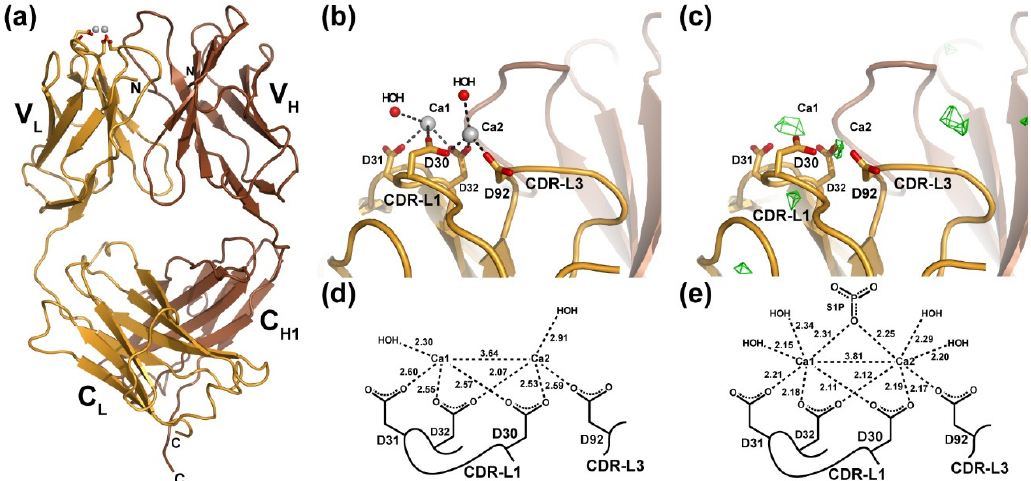
Figure 1. X-ray crystal structure of the LT1009 anti-sphingosine-1-phosphate antibody Fab fragment in complex with Ca 2+ . ( a ) The complete LT1009 Fab fragment is depicted in a ribbon diagram representation with the light chain in gold and the heavy chain in brown. Two Ca 2+ ions are represented as light grey spheres with the side chains that partially coordinate them shown as sticks. Individual immunoglobulin domains are labeled as are the N- and C-termini of the heavy and light chains. ( b ) A close-up view of the Ca 2+ binding in LT1009. Side chains from CDR-L1 and CDR-L3 that coordinate Ca 2+ are depicted as sticks and labeled, and two water molecules that are within generous hydrogen bonding distance of the Ca 2+ ions are depicted as red spheres. ( c ) An F O - F C difference electron density omit map built with phases from the apo LT1009 molecular replacement probe after rigid-body refinement and contoured at 3.5 sigma (see text) is shown in green and reveals two strong peaks at sites of the bound Ca 2+ ions. ( d ) A schematic diagram of Ca 2+ ion coordination by LT1009 with bond lengths in Å and light chain amino acids labeled. ( e ) For comparison, a similar schematic diagram of Ca 2+ coordination taken from the LT1009:S1P complex X-ray crystal structure is shown.